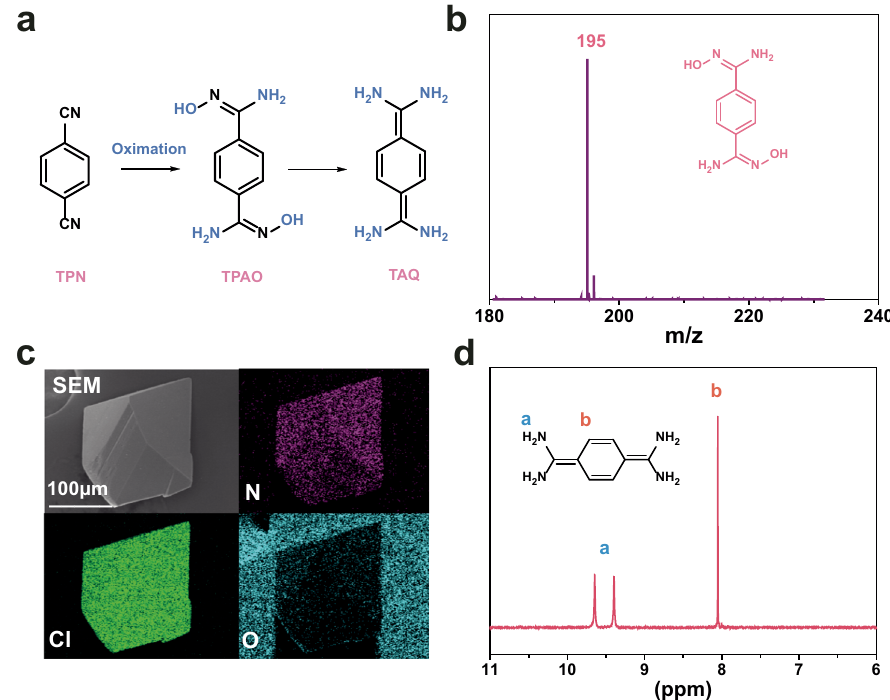
Fig. 2 Synthesis of XHOF-TAQ and characterization of the organic ligand. a Schematic diagram showing the changes of ligands for fabricating XHOF- TAQ. b The MS spectrum of TPAO. c SEM image and EDS mapping of XHOF-TAQ. d 1 H NMR spectrum of XHOF-TAQ.